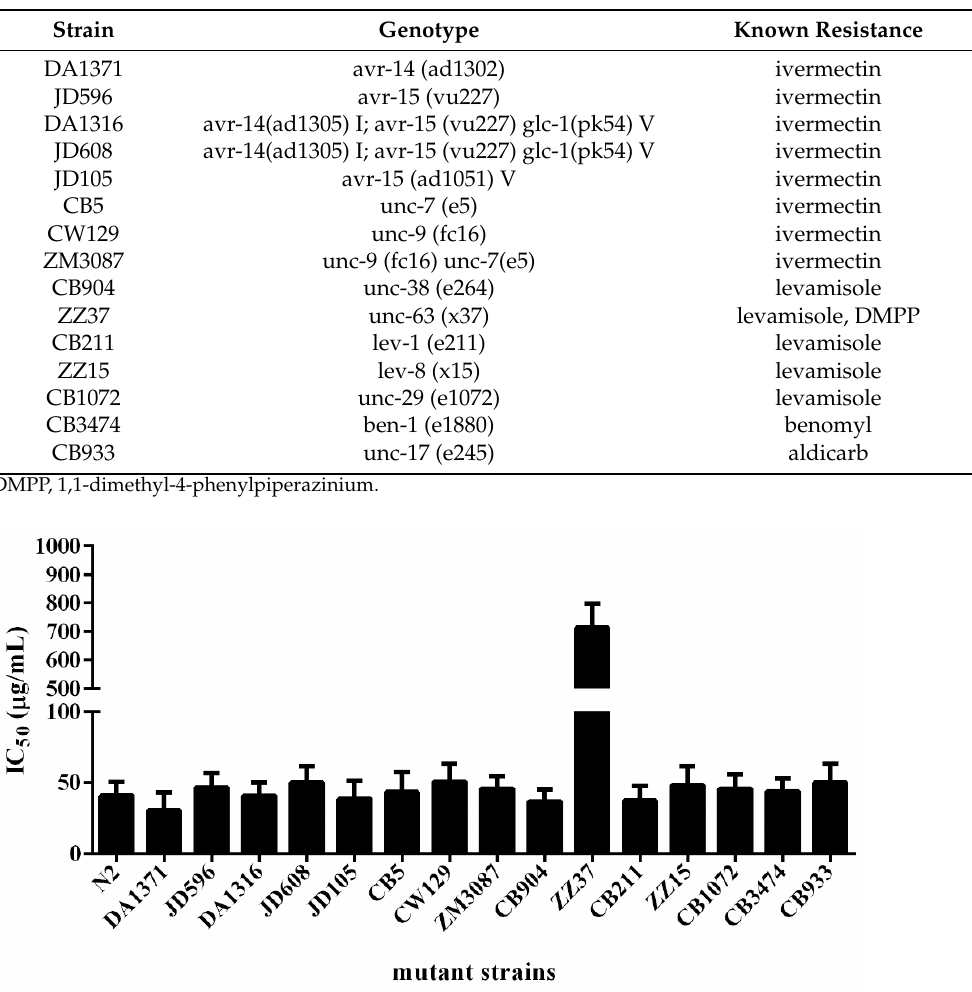
Table 2. Drug-resistant mutant strains of C. elegans used in this study.